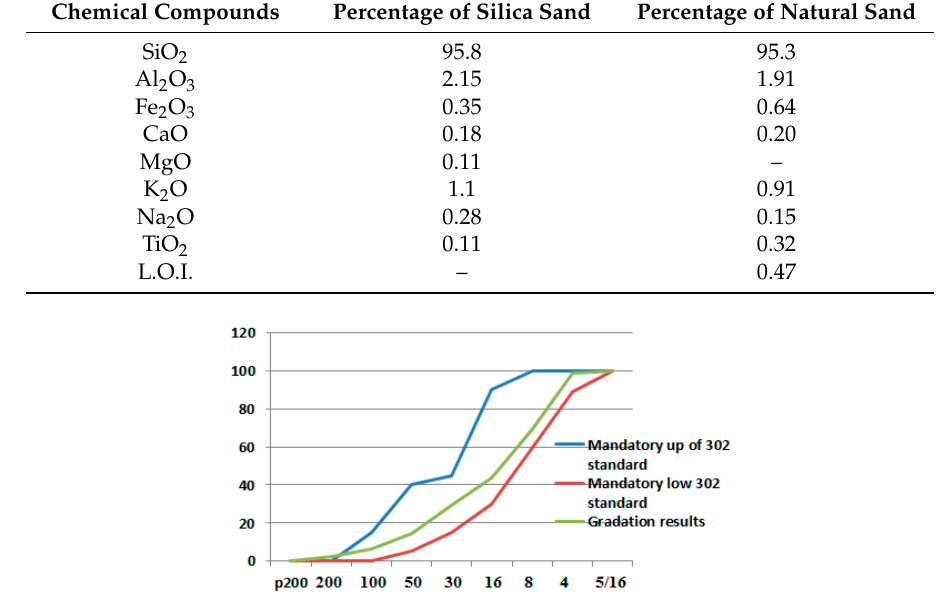
Figure 4. Sand diagram under mandatory standards. Table 8. Grading test specifications sand under mandatory standards.